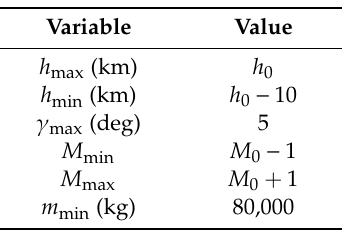
Table 3. Limits of state and path constraints.